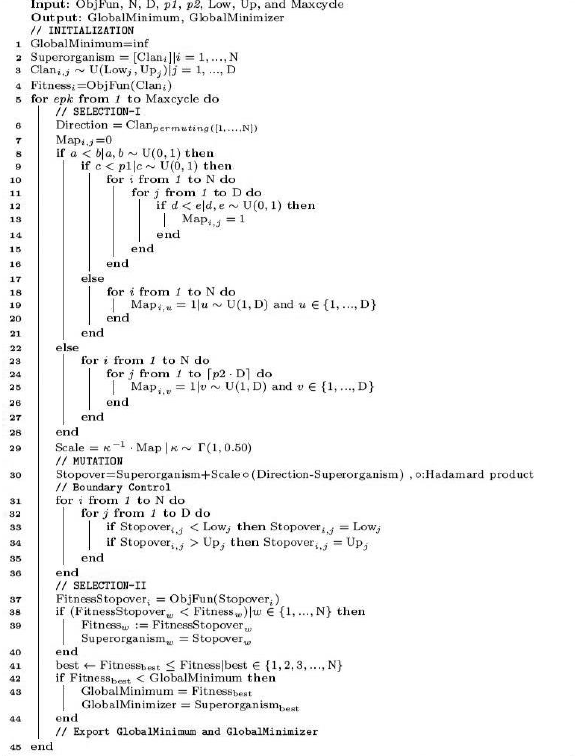
Figure 3: Pseudo code of Bijective DSA.